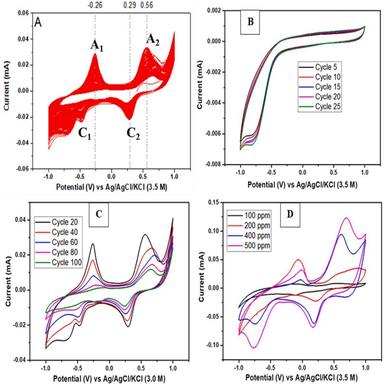
(A) CV scans of PFOA at pH 6.8 performed with PdRu|GCE vs Ag/AgCl at 100 mV/s for 100 cycles from 1.000 V to − 1.000 V. (B) CV scan of 200 ppm PFOA, performed with an unmodified (bare) GCE for 25 cycles. (C) Comparison of CV scan of 200 mg L− 1 PFOA from cycle 20–100 and (D) CV scan of 100 mg L− 1 to 500 mg L− 1 in the presence of PdRu|GCE.